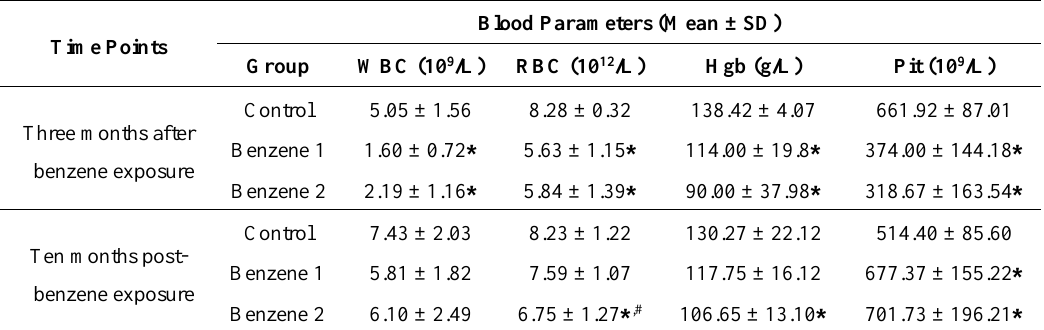
Table 3. Blood parameters of mice after benzene exposure for 3 months and at 10 months post-benzene exposure.